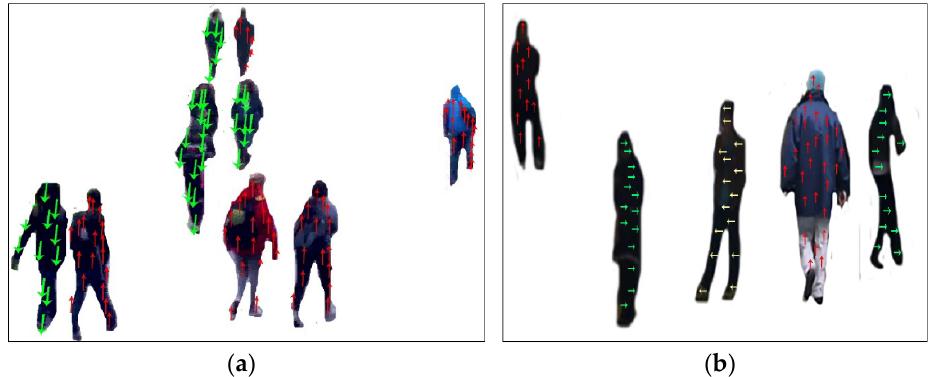
Figure 9. Deep flow features result over a crowd scene. ( a ) Shows the results from the ADOC dataset and ( b ) shows the results from the dataset.